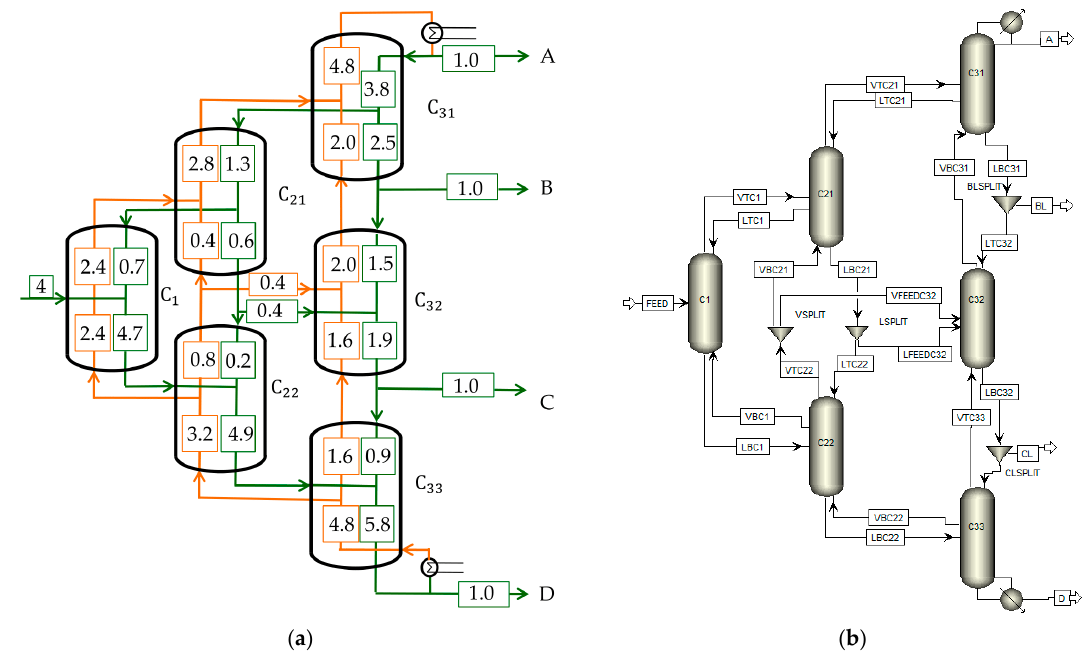
Figure 10. Six-column Petlyuk arrangement for the separation of 3-Metylhexane (A)/Toluene (B)/Ethylbenzene (C)/1-Methyl-3-Ethylbenzene (D). ( a ) Internal streams calculated with Figure 9 indicated as numbers in kmol/h, where green indicates liquid streams and orange vapor streams; and ( b ) model implemented in Aspen Plus ® for rigorous simulation. Comparing the top streams of C 22 with the bottom streams of C 21 results in a liquid, as well as vapor stream, leaving the two columns to C 32 . The streams in the opposite direction are neglected. Two splitters (LSPLIT and VSPLIT) were implemented to regulate the distribution of the streams. The values that were used for initialization are shown in Table 3. Table 3. Initial values used for rigorous simulation in Aspen Plus ® . Variable